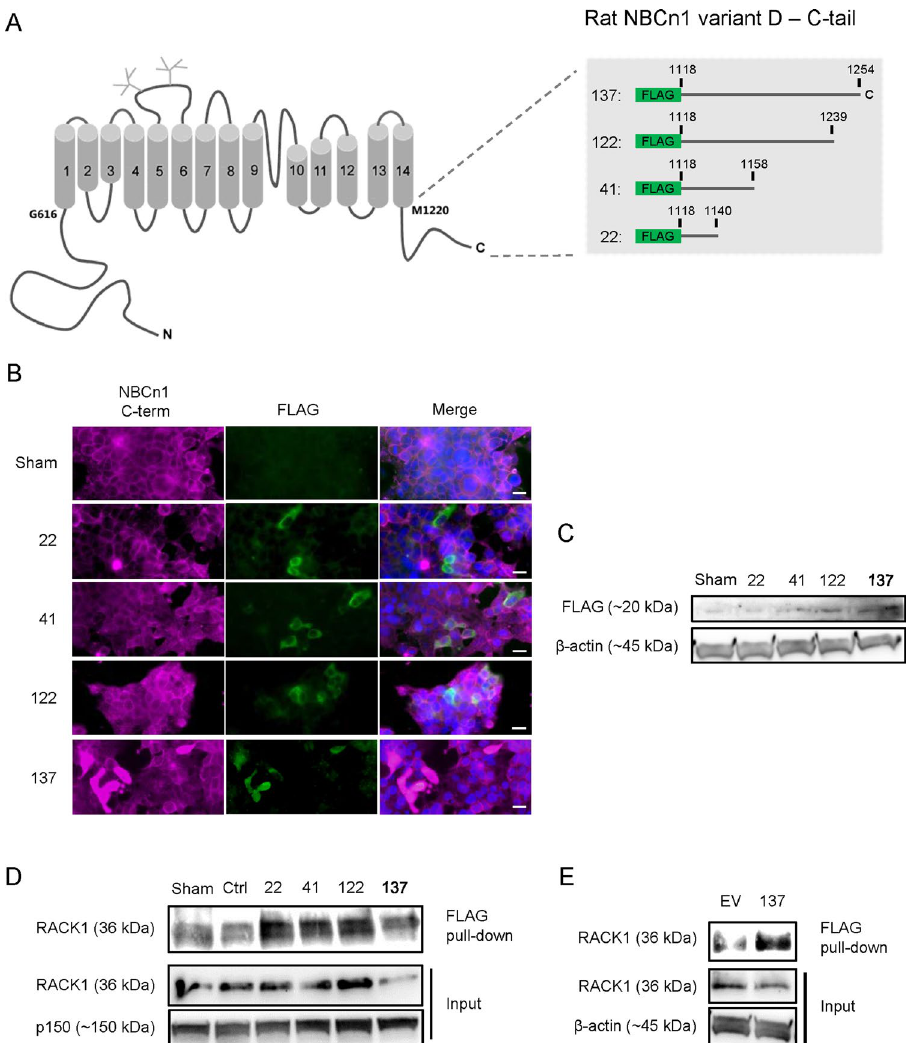
Figure 4. RACK1 interaction with FLAG-NBCn1 deletion constructs. ( A ) Overview of NBCn1 organization and the four FLAG-tagged NBCn1 constructs employed. HEK293 cells were transiently transfected with one full length (137) and three truncated (22, 41 and 122) FLAG-tagged versions of the NBCn1 C-terminal prior to lysis or PFA fixation after 24 h incubation. ( B ) Fixed cells were prepared for immunofluorescence microscopy using antibodies directed against the most distal C-terminal amino acids in NBCn1 (NBCn1 C-term) or FLAG. Scale bars: 20 µ m. ( C ) Samples from lysed cells were subjected to SDS-PAGE and Western blotting against FLAG and β -actin (loading control). ( D ) Samples from lysed cells were subjected to FLAG IP and analyzed by SDS-PAGE and Western blotting against RACK1 and p150 (loading control). Ctrl: isotype control. Sham: sham-transfected cells. ( E ) HEK293 cells were transfected with empty vector pFLAG-CMV-2 (EV) or full length NCBn1 C-terminus (137) and lysed before performing IP against FLAG and analyzing by SDS-PAGE and Western blotting against RACK1 and β -actin (loading control). Representative images from 3–4 independent experiments are